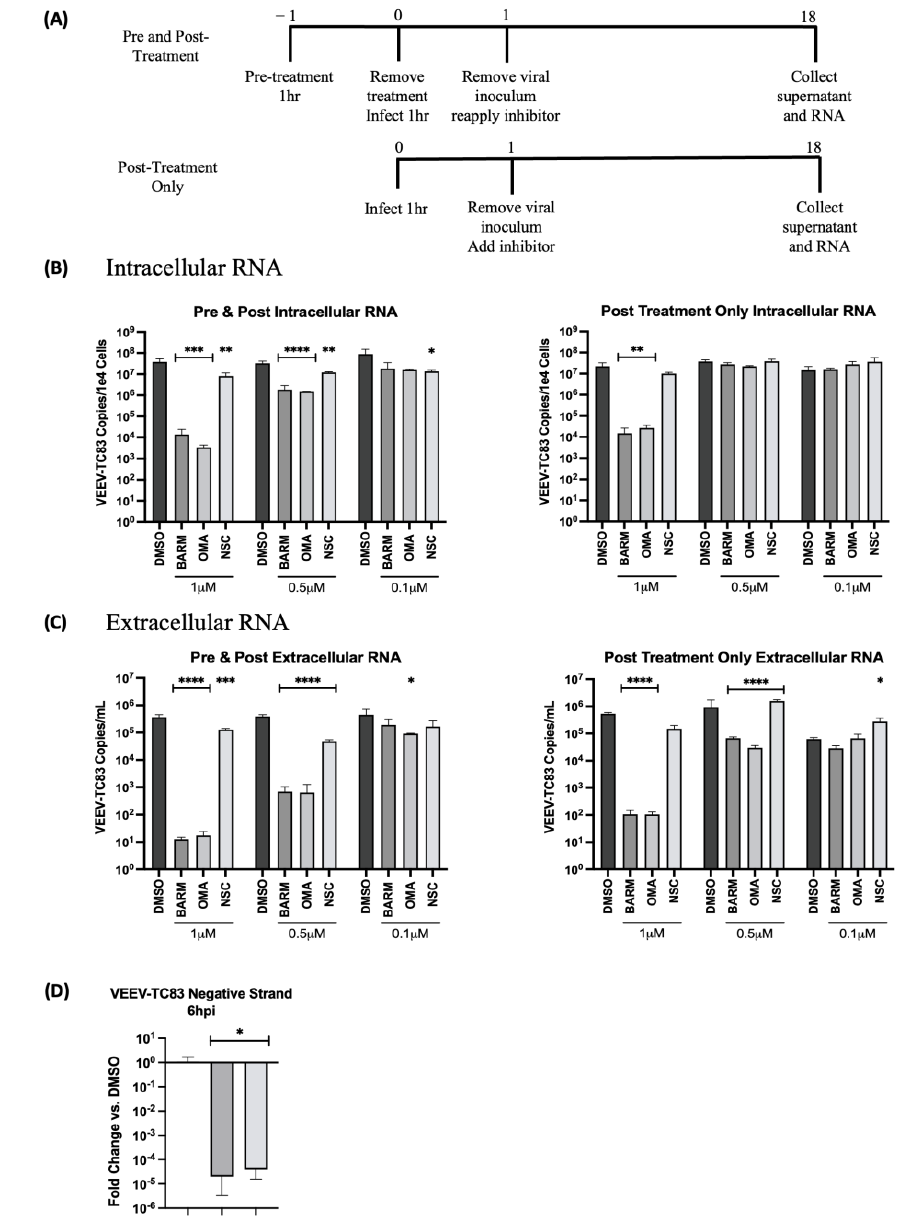
Figure 5. OMA, BARM and NSC showed a dose-dependent decrease in VEEV-TC83 RNA when inhibitor was present pre- and post-infection. ( A ) HMC3 cells were treated with the inhibitor either pre- and post-infection or post-infection only at different concentrations as indicated. Following infection for 1 h, the viral overlay was replaced with media containing the inhibitors. Viral RNA from culture supernatants and cells were collected at 18 h post-infection. ( B ) Intracellular viral RNA load and ( C ) extracellular viral RNA levels were analyzed by qRT-PCR and data reported as genomic copies per cell (intracellular) or per mL (extracellular). ( D ) Quantitative analysis of negative-strand RNA was performed with OMA and BARM. Statistical analysis determined using One-way ANOVA with Dunnett’s post -test. * p < 0.05, ** p < 0.01, *** p < 0.001, **** p < 0.0001.